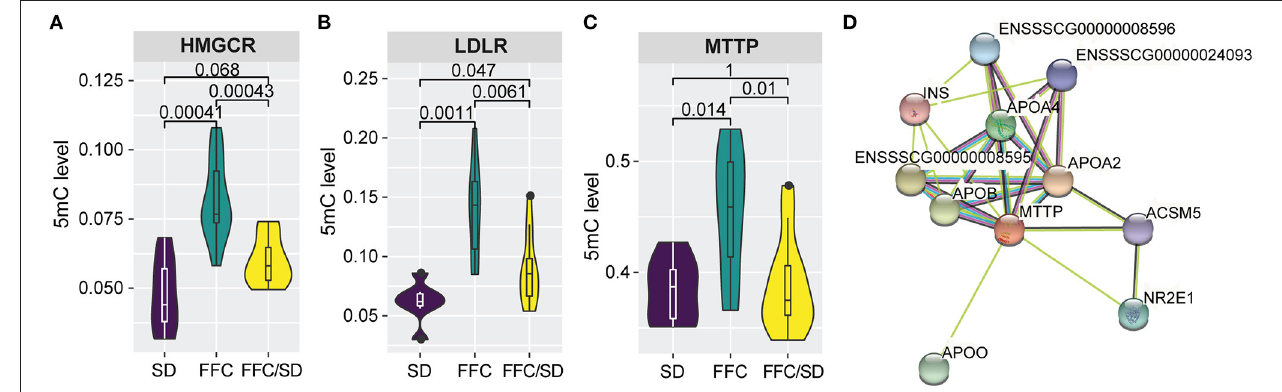
FIGURE 2 | Methylation changes associated with lipid/cholesterol metabolism. (A–C) Boxplot of methylation level of promoter regions of HMGCR (A) , LDLR (B) , and MTTP (C) . P -values were calculated using Mann-Whitney U -test. (D) Construction of protein-protein interaction networks using STRING database (v11.0). Edges represent protein-protein